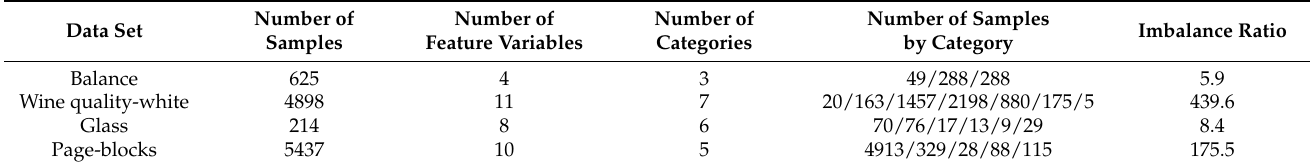
Table 1. Data set